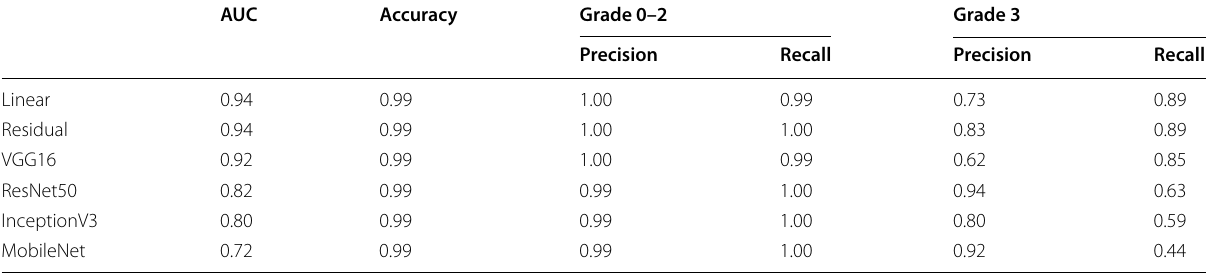
area under the curve; Precis =